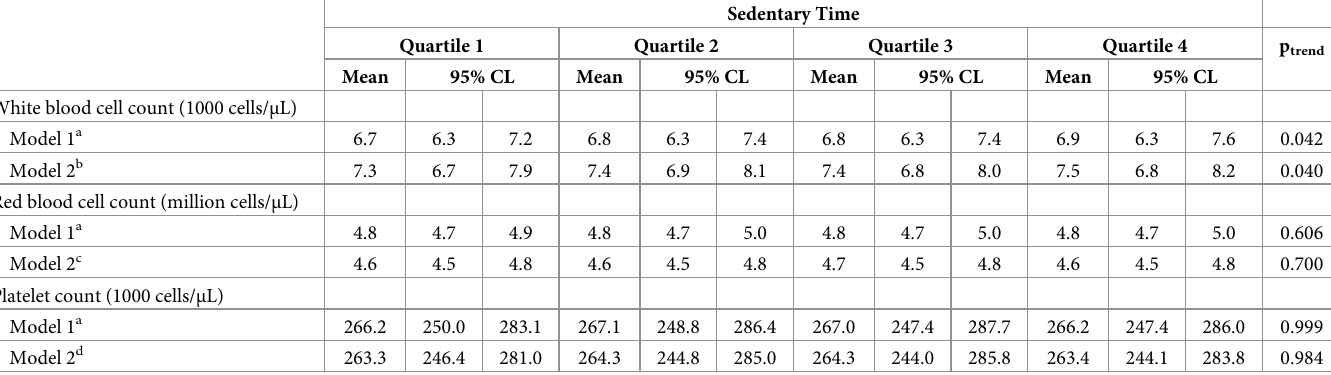
Table 5. Adjusted means (95% CL) for continuous hematologic variables across quartiles of total sedentary time in U.S. adults (cid:21) 20 years (NHANES